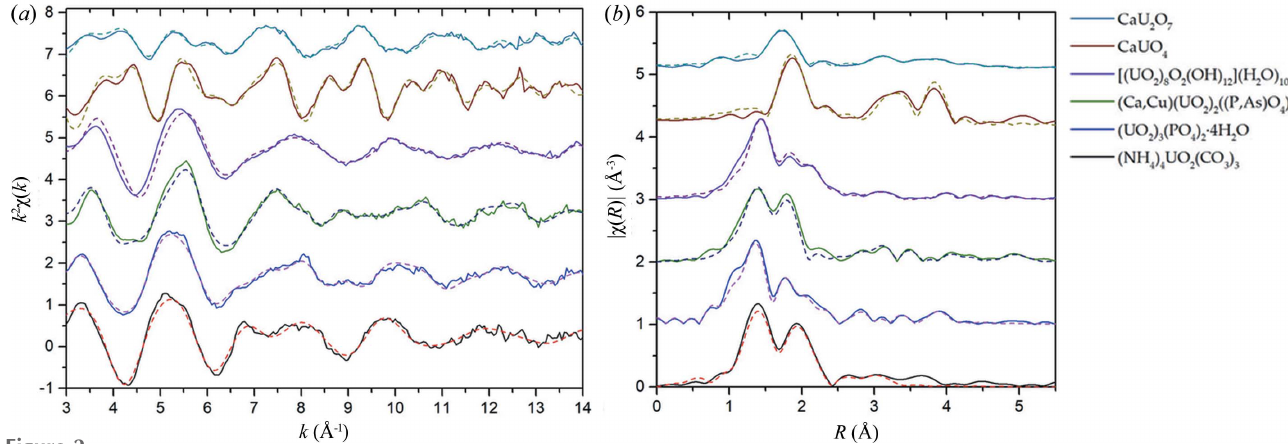
Figure 2 ( a ) U L III -edge k 2 -weighted EXAFS spectra; ( b ) Fourier transform magnitude, not corrected for phase shifts. The dotted lines represent fit curves.